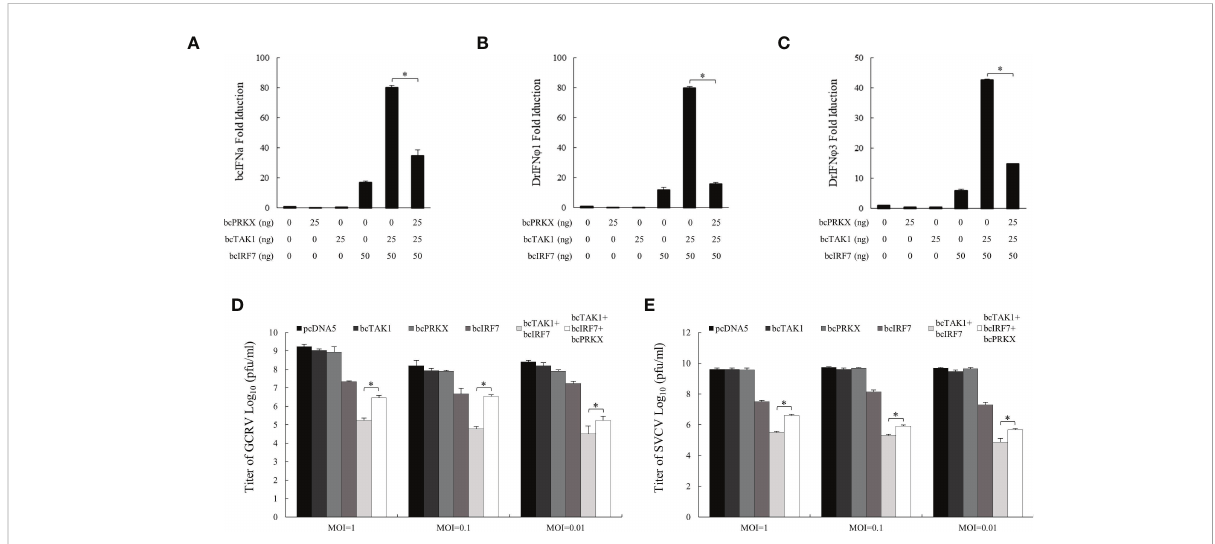
FIGURE 7 bcPRKX suppressed bcTAK1/bcIRF7/IFN signaling. (A-C) EPC cells were co-transfected with Luci-bcIFNa or DrIFN f 1/3, pRL-TK, bcTAK1, bcIRF7 and/or bcPRKX respectively. At 24 h post-transfection, the cells were subjected to luciferase reporter assay according to the methods. (D, E) EPC cells were transfected with bcPRKX, bcTAK1 or bcIRF7 separately, or co-transfected with bcTAK1 and bcIRF7, with or without bcPRKX. At 24 h post-transfection, the cells were infected with SVCV or GCRV separately, and the media were titrated at 24 h post-infection. Asterisk (*) stands for statistical difference